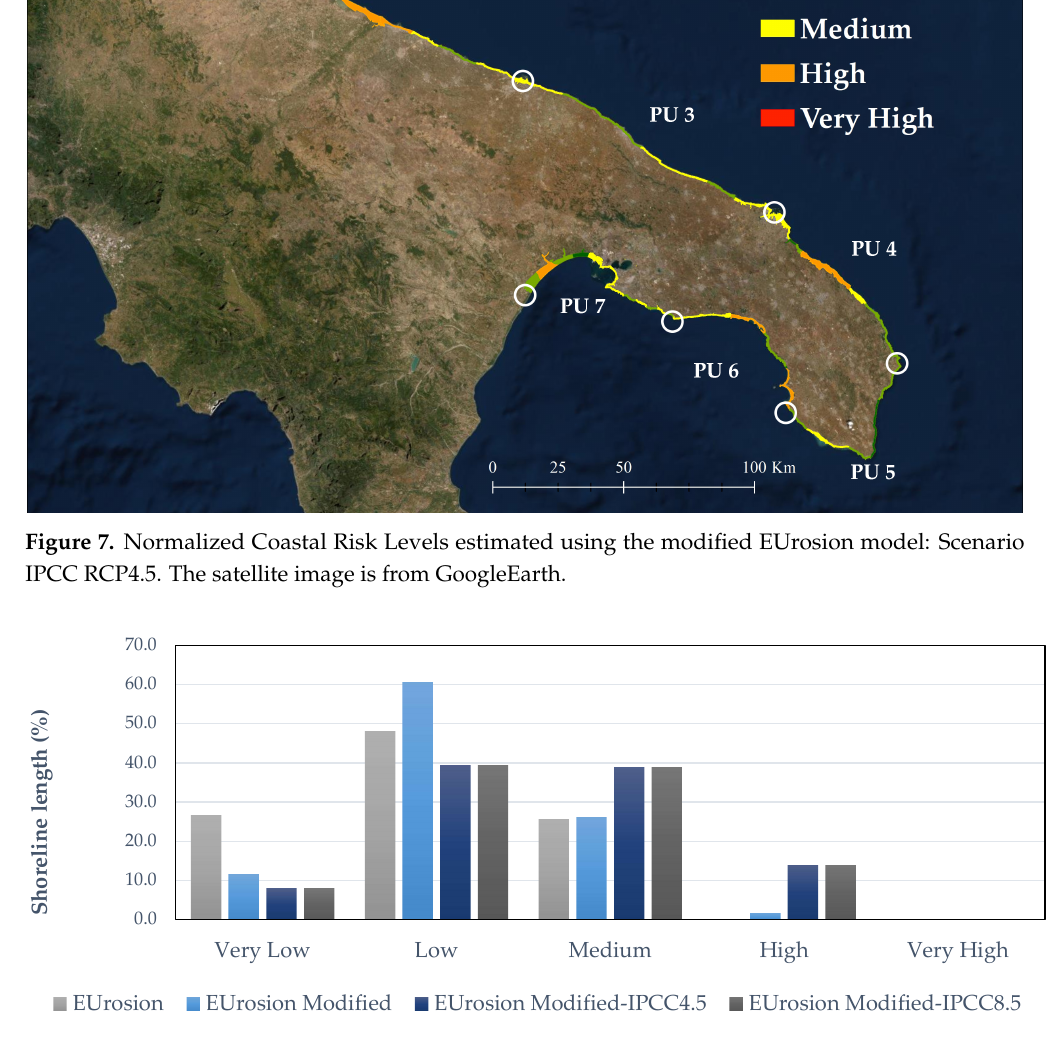
Figure 8. Comparison of results obtained using different approaches and